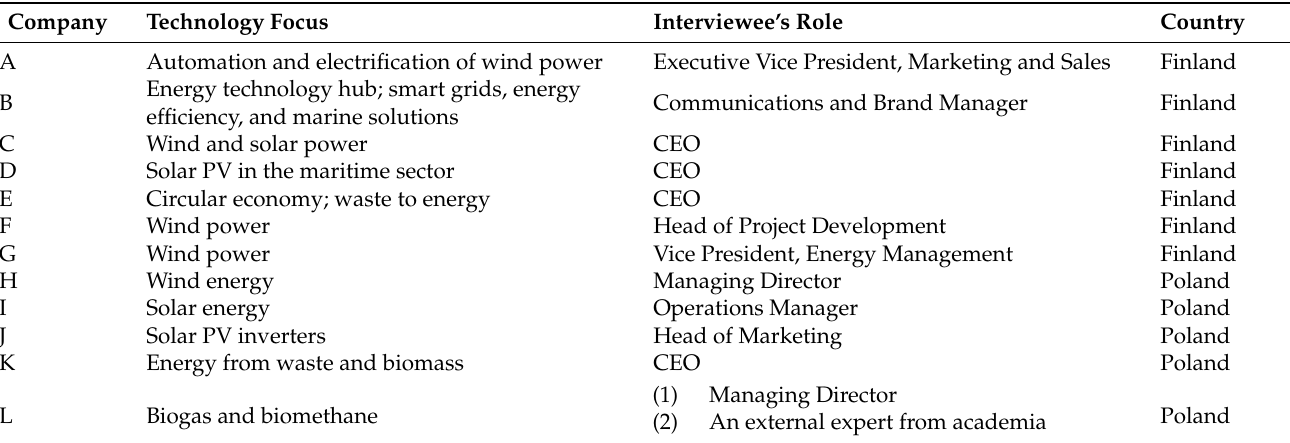
Table 2. Details of companies in the case